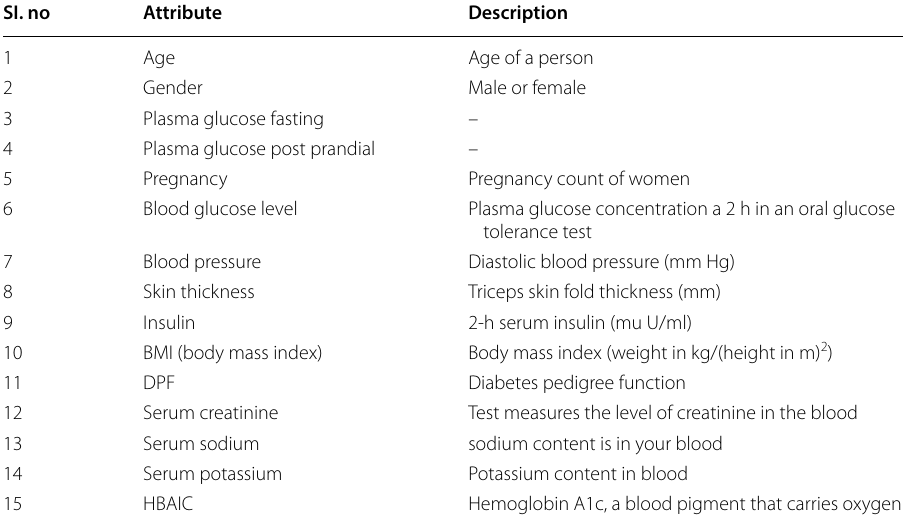
Table 1 Description of Data set SI.